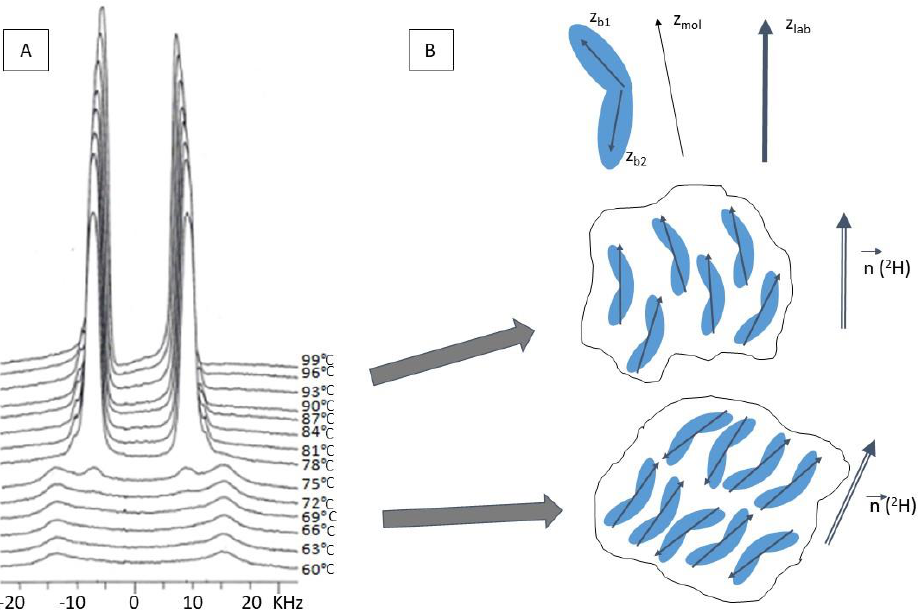
Figure 4. ( A ) Stackplot of 2 H NMR static spectra of the 10DClPBBC-d 4 sample, recorded by heating the sample from the crystal phase, without 1 H decoupling. Measurements were performed from 60 ◦ C to 99 ◦ C every 3 ◦ C. Note the biphasic spectrum at T = 75 ◦ C. ( B ) Sketch of a local micro-domain of bent molecules and the relative average orientation of their molecular axis according to 2 H NMR results, in the nematic phase, at high temperatures, and in a smectic-like or crystalline-like phase, at low temperature, as discussed in the text. The orientation of relevant axes is indicated by black arrows, as described in the text.